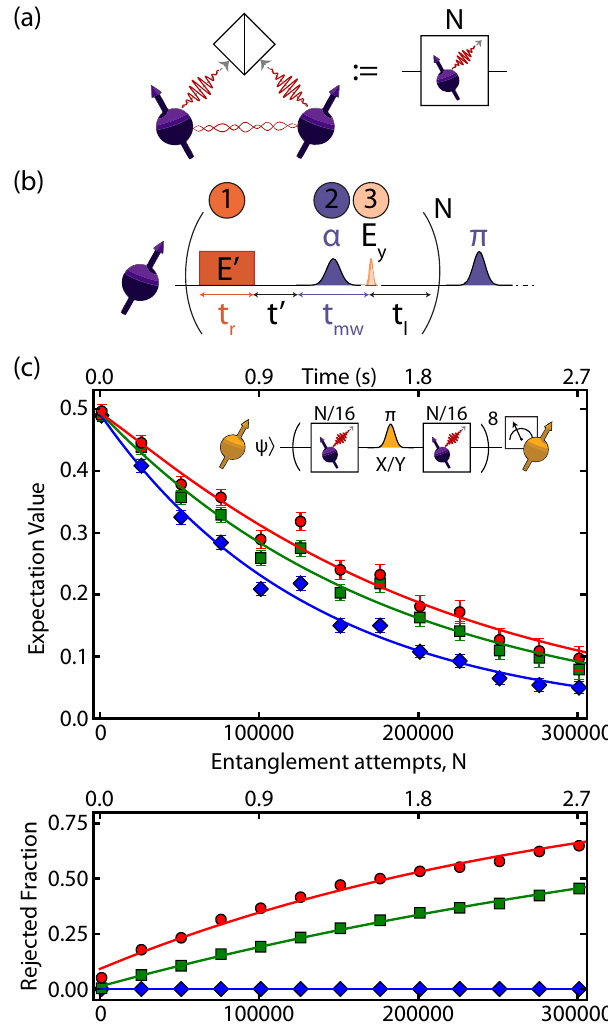
Fig. 2 Memory robustness under remote-entanglement genera- tion. a Sketch of a remote-entanglement process. After generation of local spin-photon entanglement at each node (see ( b )), a detection event at a central beamsplitter heralds remote entangle- ment. Due to loss processes, the protocol is probabilistic. b Remote- entanglement primitive: (1) The electron spin is reset by an optical pulse of duration t r = 5 μ s. (2) After a time t 0 ¼ 200 ns, a microwave pulse of duration t mw = 2.8 μ s prepares a spin superposition state. (3)